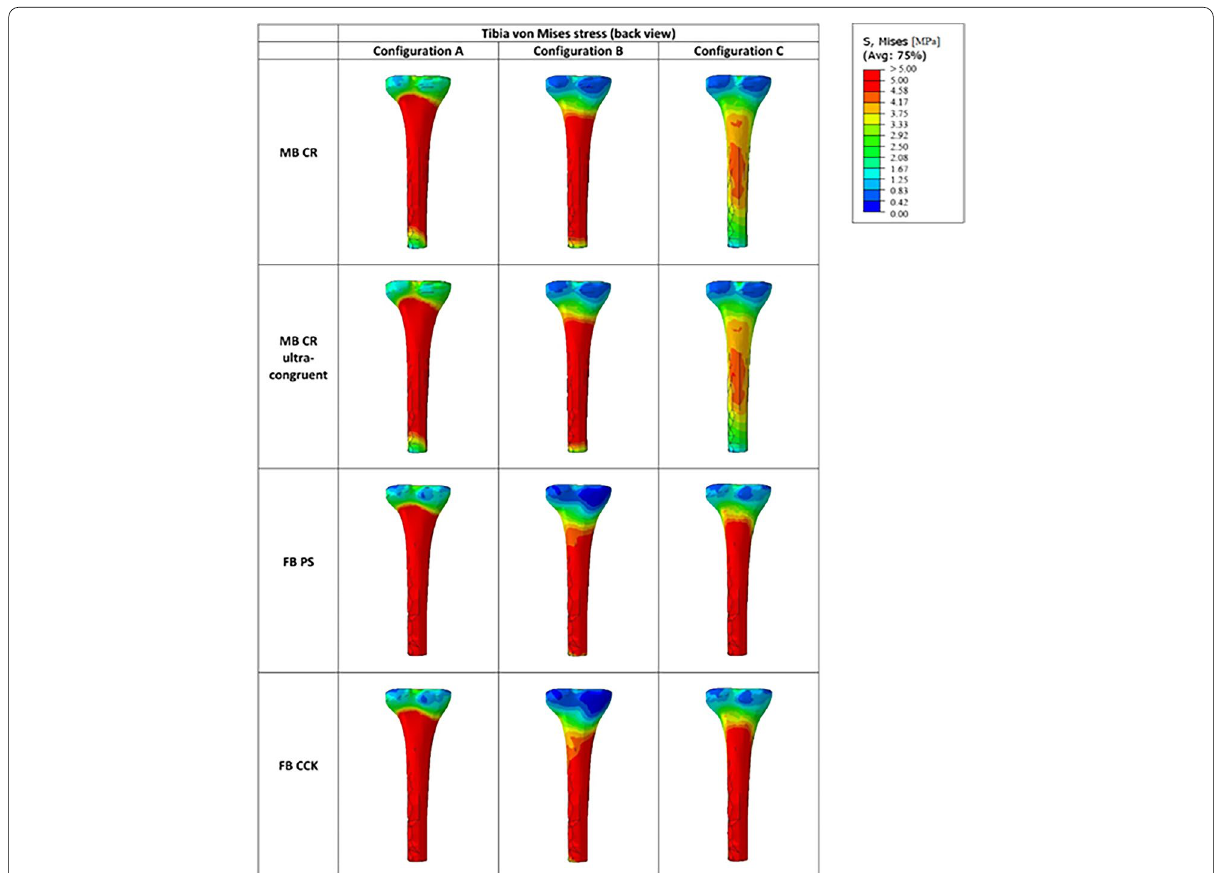
Fig. 11 Qualitative overview of the von Mises stress along the tibial bone for all the considered models in the three studied configurations (posterior view)